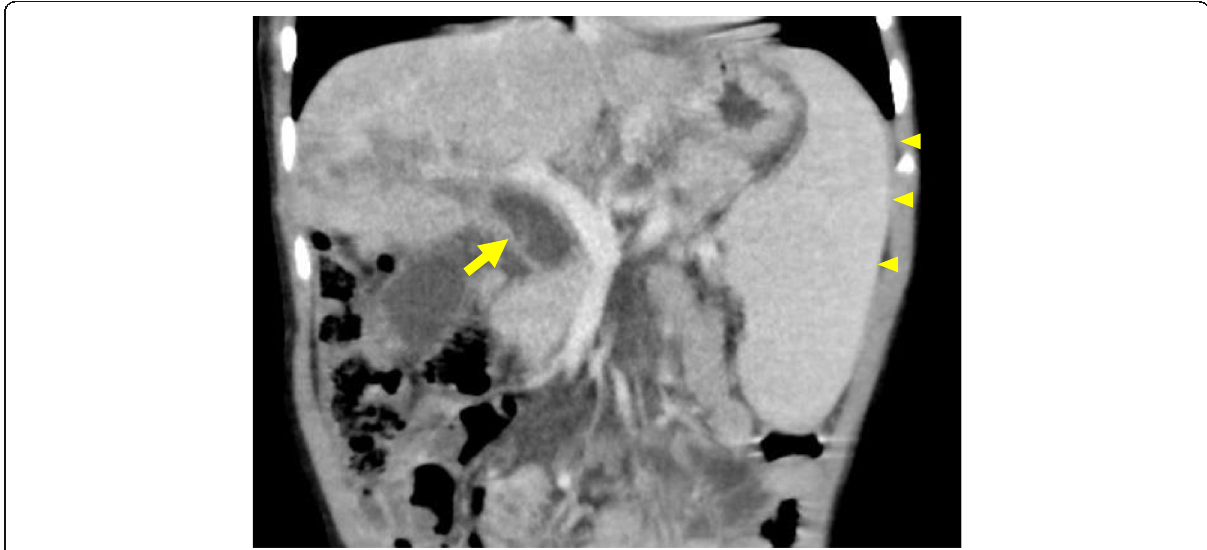
Fig. 1 Contrast-enhanced computed tomography of the abdomen (coronal view). The common biliary duct was dilated (arrow). The right hepatic lobe was extremely atrophied, and splenomegaly was recognized (arrow